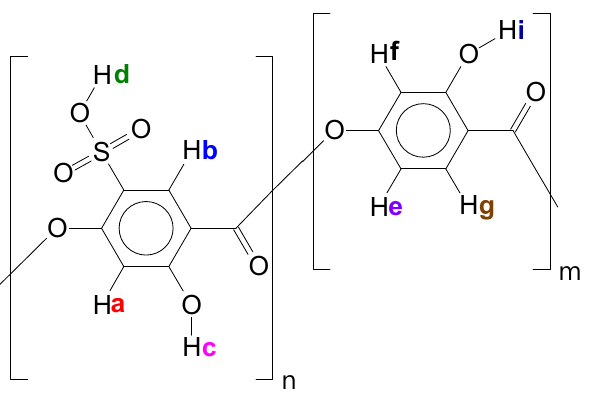
Figure 11. Poly(2,4-dihydroxy-5-sulfobenzoic acid) molecular structure with labeled